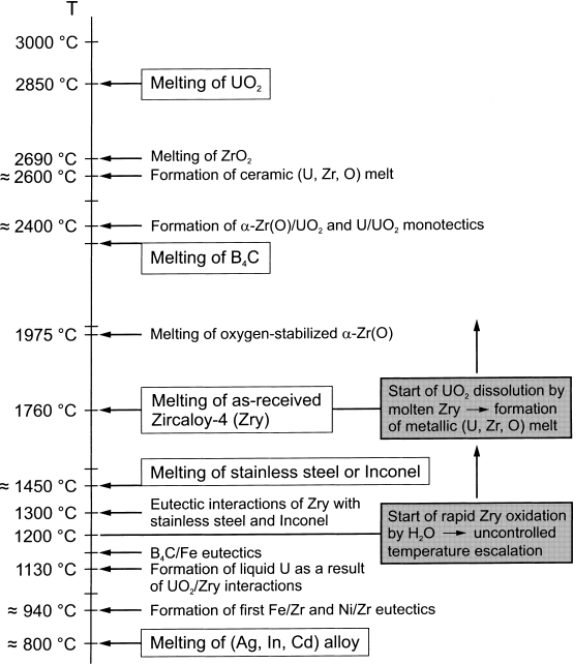
Figure 5. LWR severe accident-relevant melting and chemical interaction temperatures which result in the formation of liquid phases